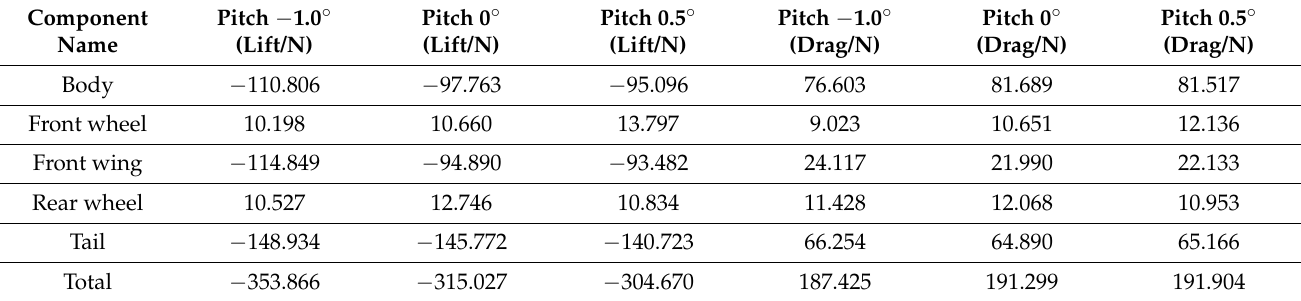
Table 4. Lift data and drag data of racing components in pitching conditions of − 1.0 ◦ , 0 ◦ and 0.5 ◦